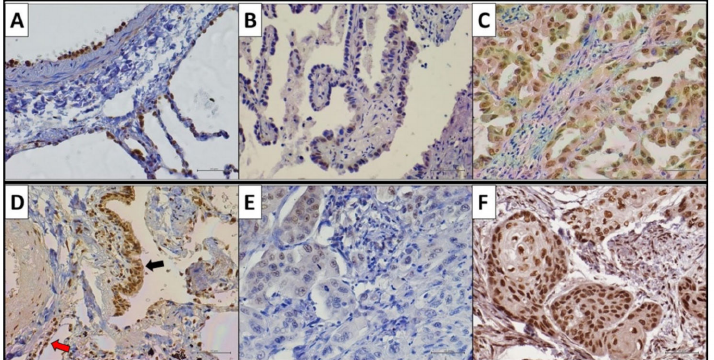
Figure 1. Immunohistochemical PATZ1 expression in NSCLC and peritumoral tissue. ( A – C ) Repre- sentative staining of PATZ1 in LUAD samples and peritumoral tissue. ( D – F ) Representative staining of PATZ1 in LUSC samples and peritumoral tissue. ( A ) PATZ1 nuclear expression in normal pneu- mocytes; ( B ) PATZ1 nuclear expression in <20% of LUAD cells (low-expressor LUAD); ( C ) PATZ1 nuclear expression in ≥ 70% of LUAD cells (high-expressor LUAD); ( D ) PATZ1 nuclear expression in normal pneumocytes (red arrow) and nuclear and cytoplasmic expression in bronchiolar cells (black arrow) with stronger nuclear staining; ( E ) PATZ1 nuclear expression in <20% of LUSC cells (low-expressor LUSC); ( F ) PATZ1 nuclear expression in ≥ 70% of LUSC cells (high-expressor LUSC). Scale bar: 50 µ